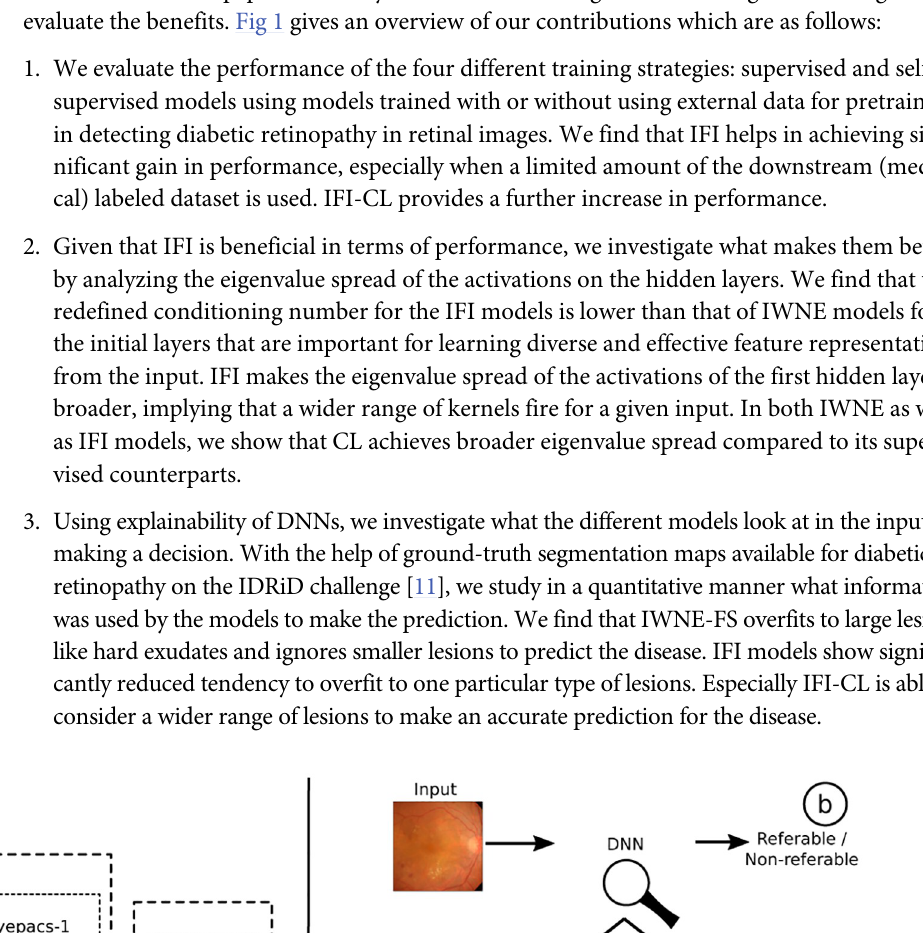
PLOS ONE | https://doi.org/10.1371/journal.pone.0274291 October 18,